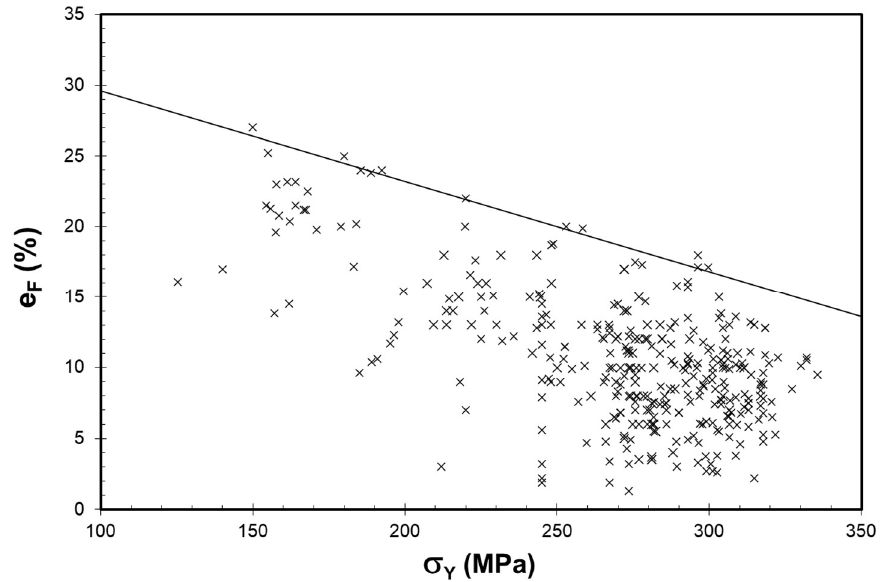
Figure 1. Elongation plotted versus yield strength for cast Al-7%Si-Mg alloy specimens excised from production castings (redrawn from data reported previously [13]).